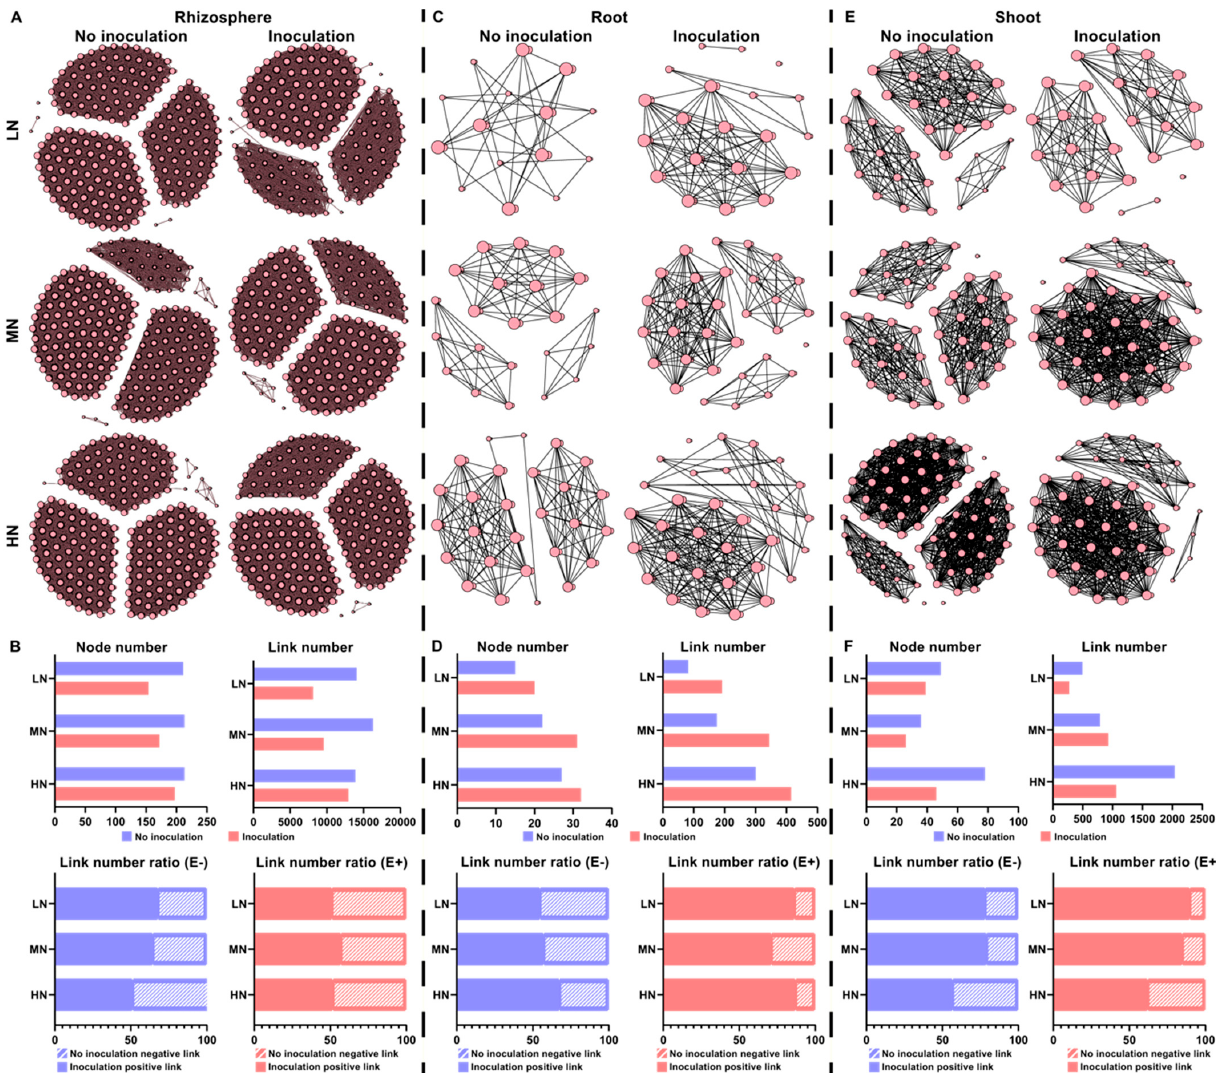
Figure 8. Co-occurrence network of biology–biology, representing the bacterial interactions in the rhizosphere ( A ), root ( C ) and shoot ( E ) at different nitrogen levels. The topological characterizations include the node number, link number and link number ratio (positive link versus negative link; ( B , D , F )). The connections are Spearman correlations with significance ( p < 0.05) and high significance (0.6 < |r| < 1).